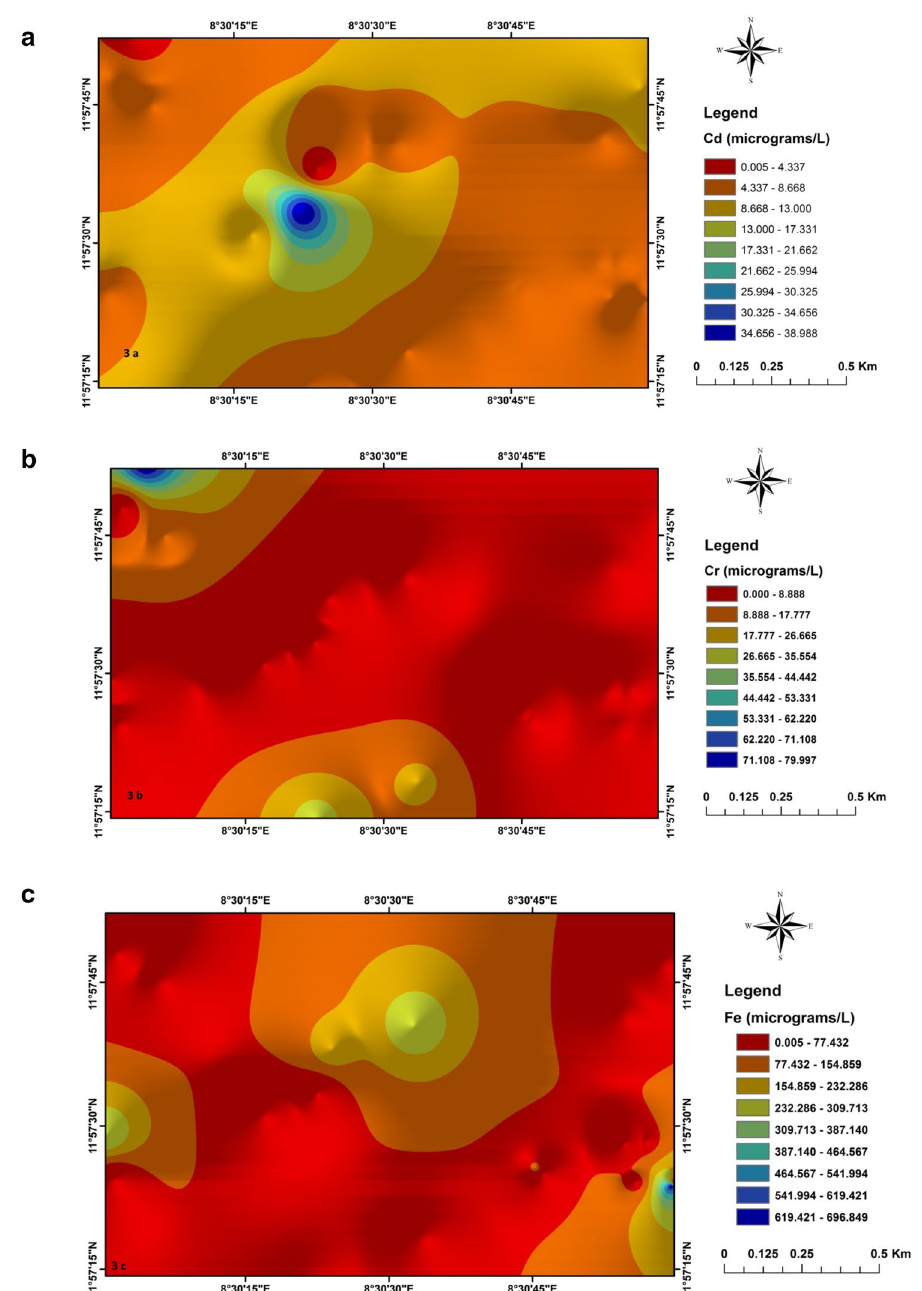
Fig. 3 a – f Spatial variation maps of analyzed Heavy in the groundwater of Sharada and Challawa industrial area note the difference in the concen- trations of the metals between the two